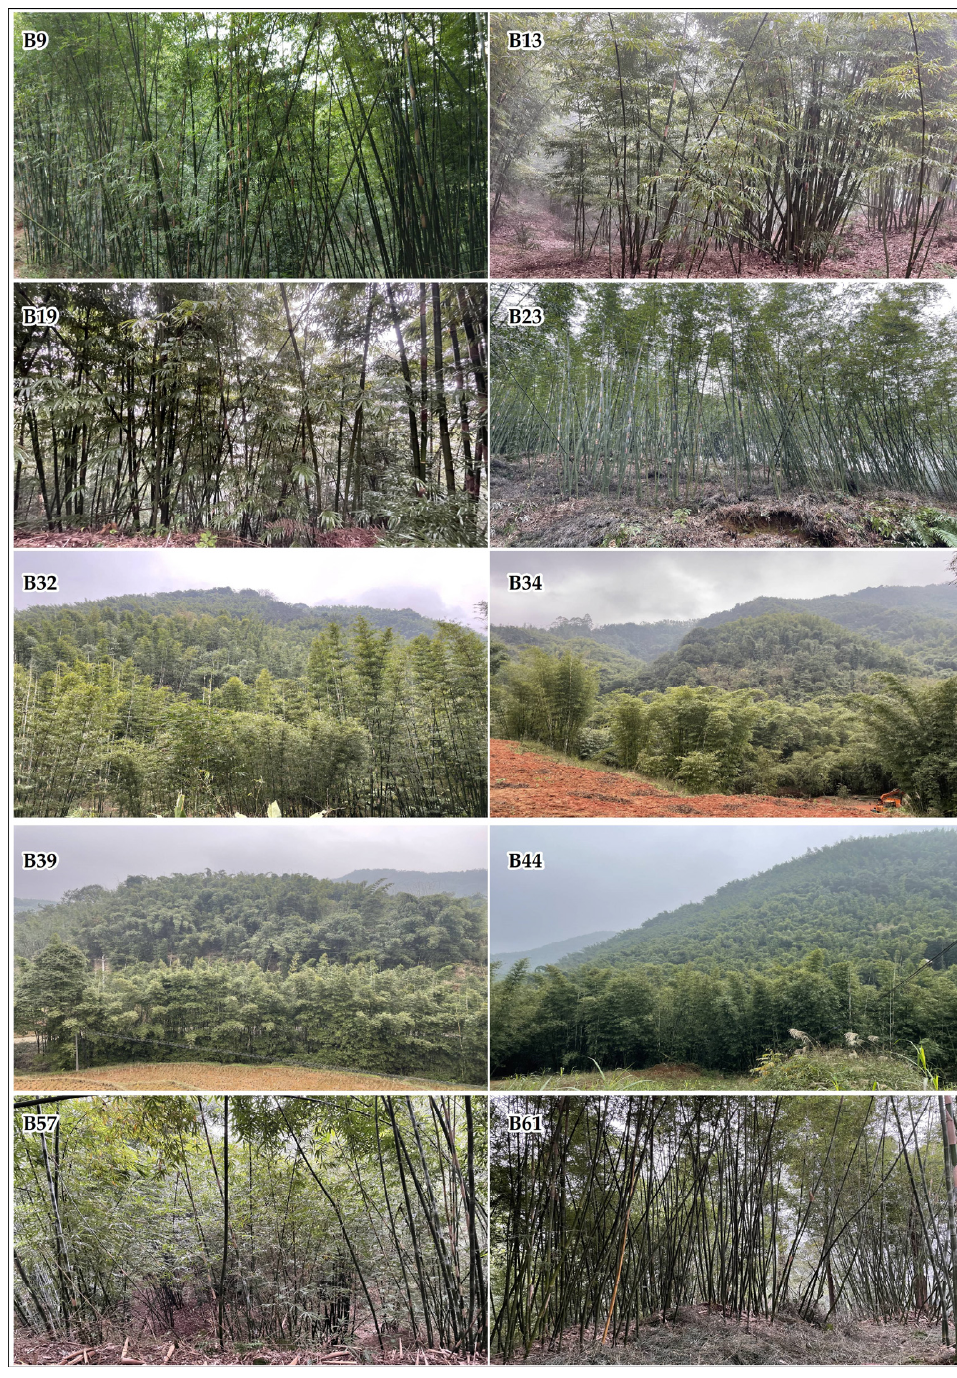
Figure A2. Photos of some Bambusa emeiensis validation points from the field survey.